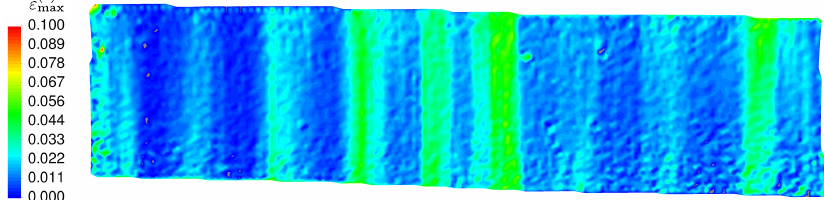
( 2 ) max using a facet size of 19 px with a point